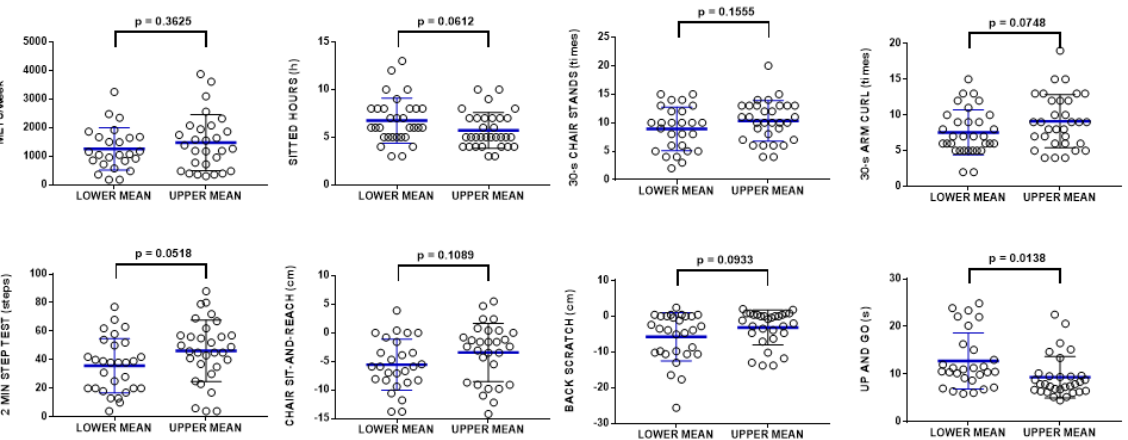
Figure 5. Score of the different test of the SFT depending on the levels of CoQ 10 in plasma. Mean CoQ 10 levels were designated as 0.8 μ M, and the scores of the participants grouped depending on whether their CoQ 10 levels in plasma were above or below this mean. Data represent the mean ± SD of the whole population (n = 64).